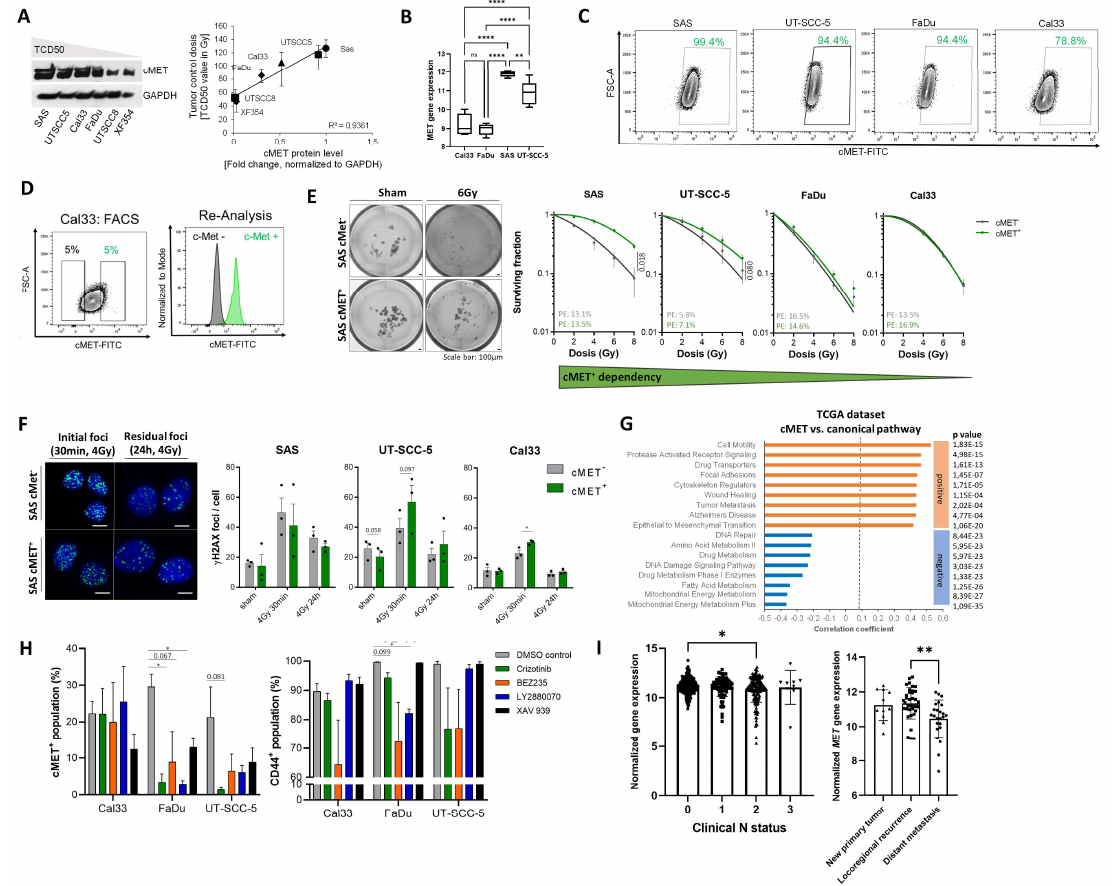
Figure 2. Functional properties of the high c-MET-expressing population in HNSCC. ( A ) Western blot analysis for c-MET protein and correlation to tumor control doses 50% (TCD50) as indicator of tumor radiosensitivity. ( B ) Gene expression analysis of MET in Cal33, FaDu, SAS, and UT-SCC-5 cell lines derived from xenograft tumors that were further correlated to previously published tumor control dose 50% (TCD50) values [39–41]. ( C ) Proportions of c-MET positivity in different HNSCC cell lines were analyzed by flow cytometry. ( D ) Purification of c-MET high- and low-expressing cell